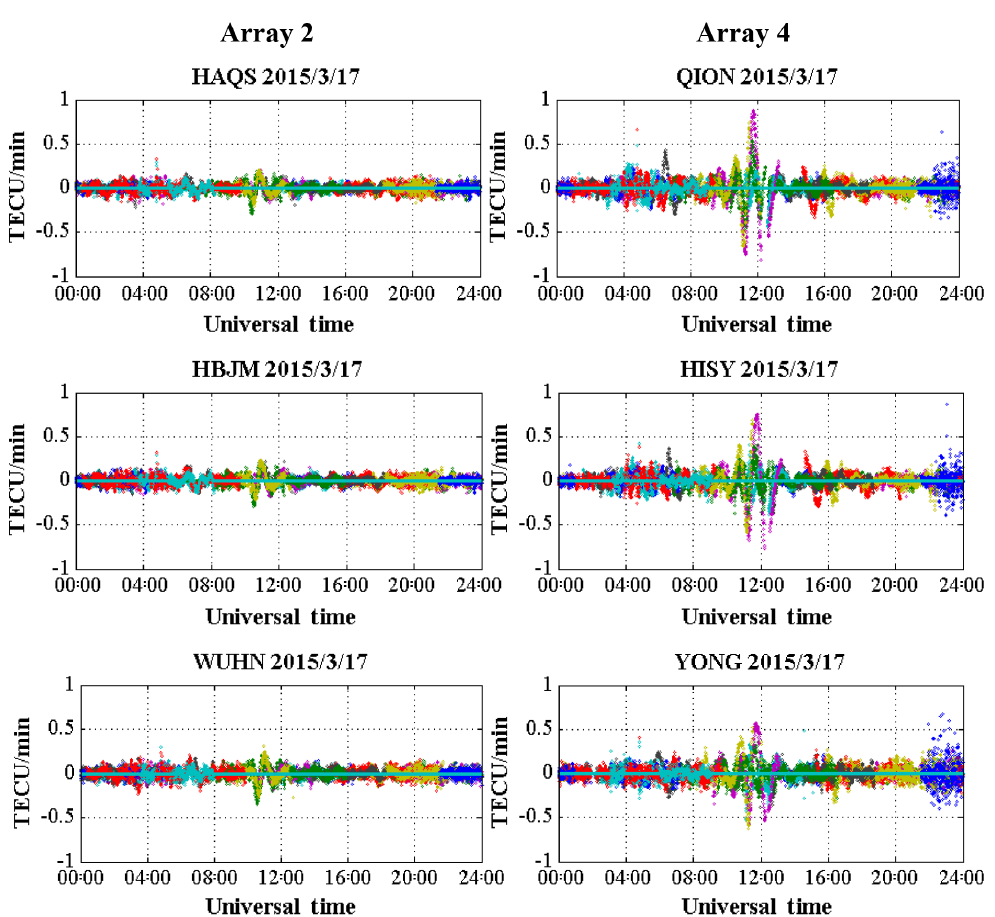
Figure 5. Time series of DROVT obtained in GPS stations with Array 2 (HAQS-HBJM-WUHN) and Array 4 (HISY-QION-YONG) on 17 March